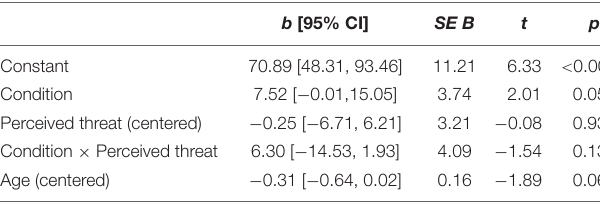
TABLE 3 | Linear model of condition and perceived threat predicting memory performance.